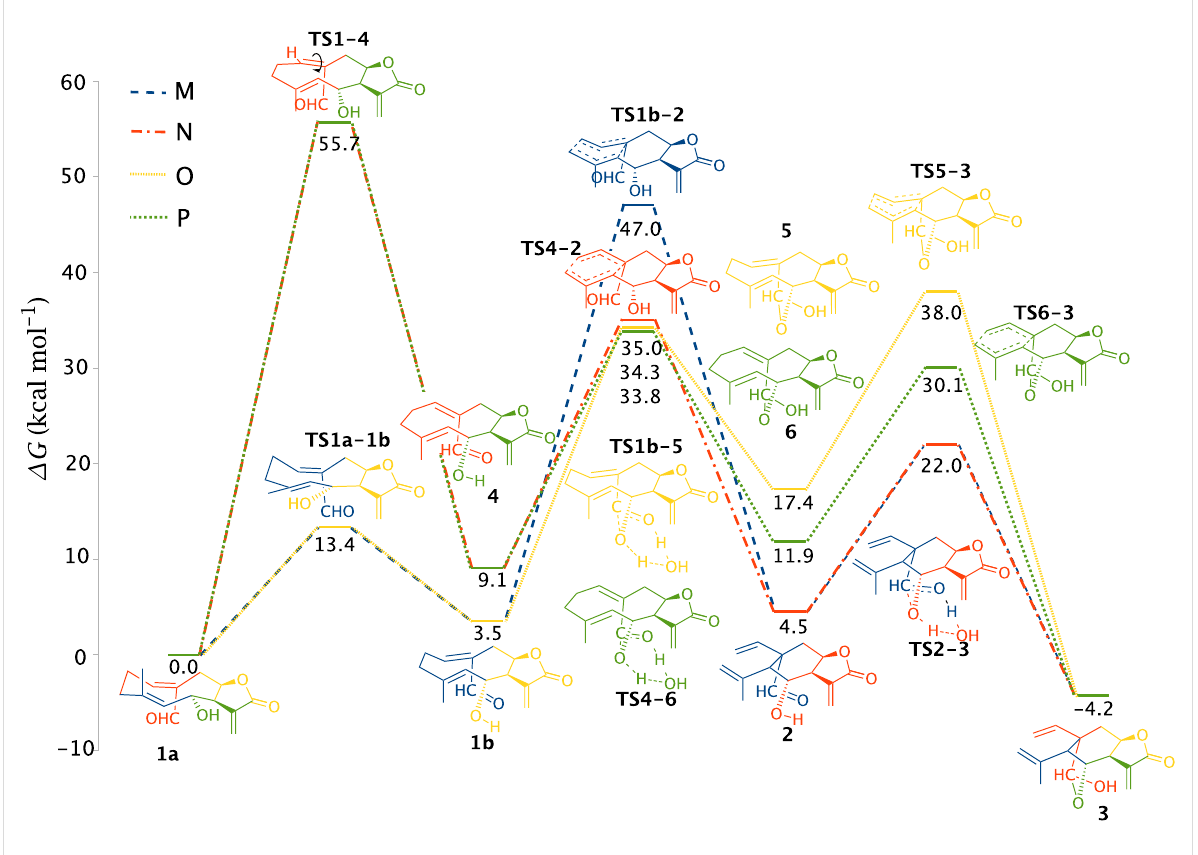
Figure 1: Reaction paths M (blue), N (orage), O (yellow) and P (green) for the transformation of 1 into 3 . Relative free energies in kcal/mol. The ener- getic barriers for the hemiacetalization steps are calculated including a water molecule to facilitate the proton